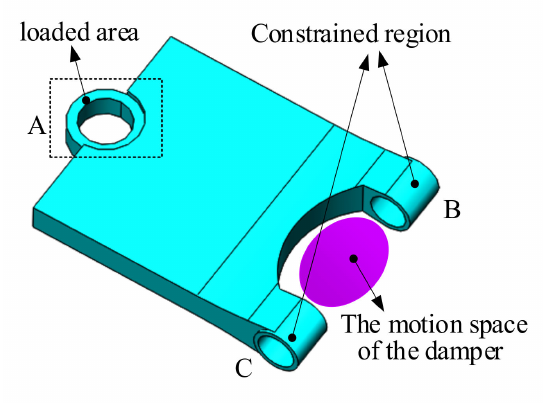
Figure 9. The envelope model of the control arm.